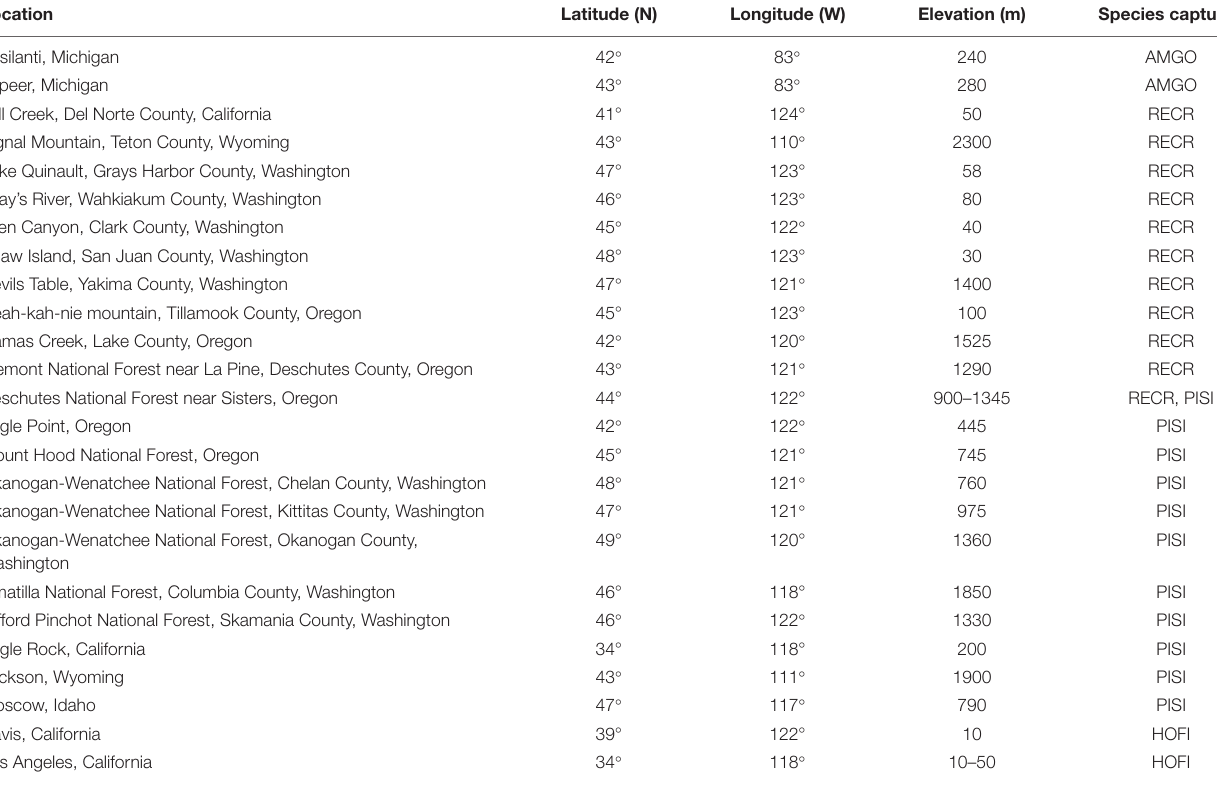
TABLE 1 | Primary capture locations in the United States for American goldfinches (AMGO), red crossbills (RECR), pine siskins (PISI), and house finches (HOFI).